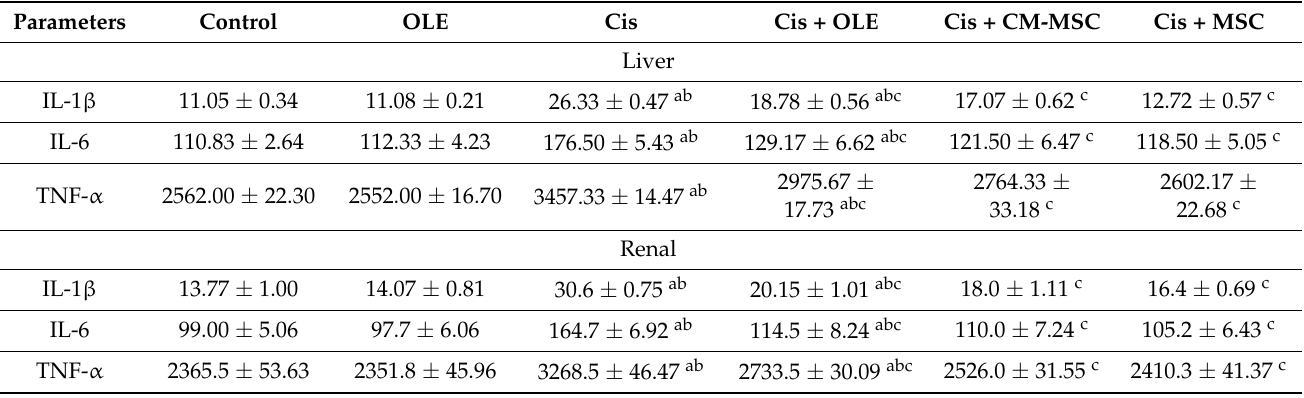
Table 5. Effects of olive leaf extract (OLE), mesenchymal stem cells (MSC), CM-MSC, cisplatin, and their combination on the liver and renal levels of inflammatory markers of